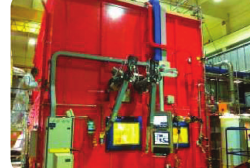
Fig. 9. Remote manipulators.